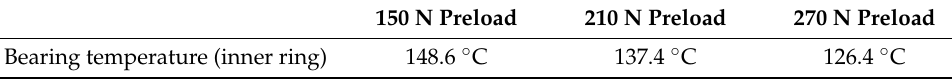
Table 6. Steady state maximum bearing temperatures in an electric motor for FESS.